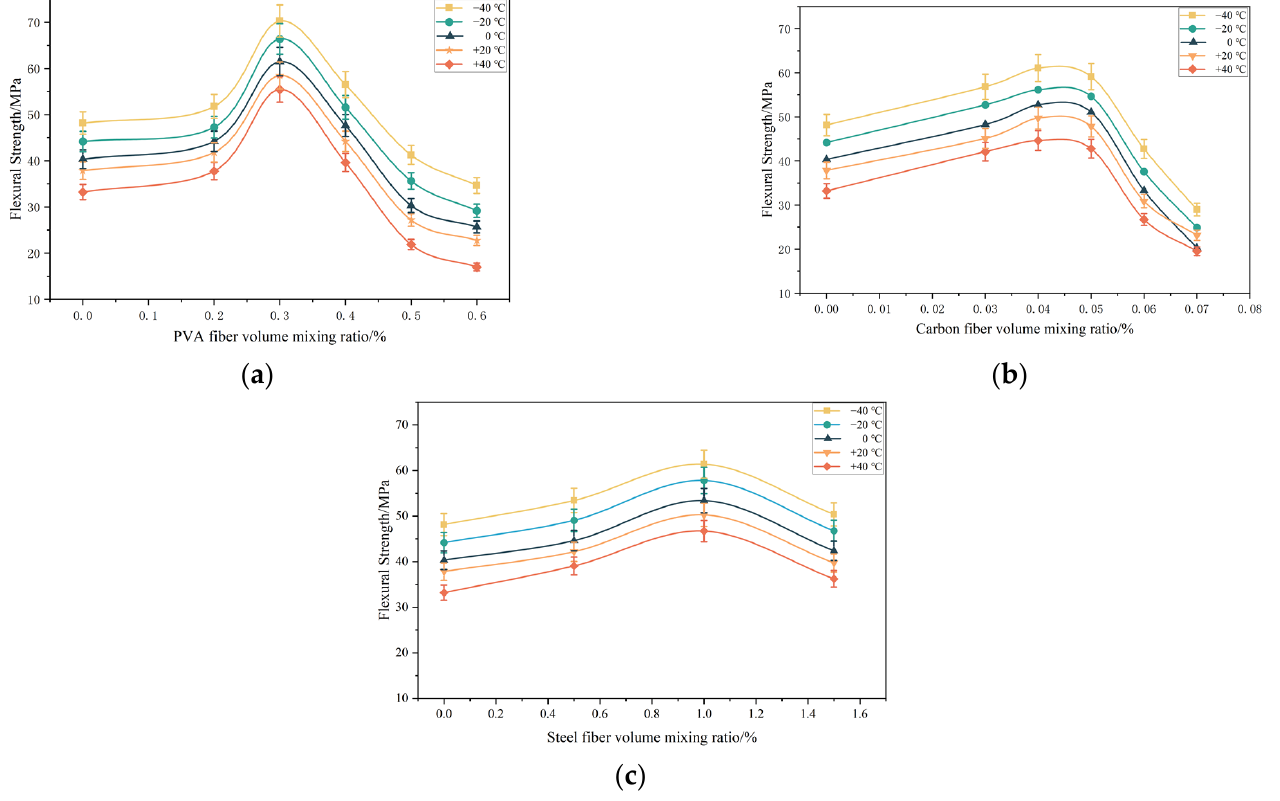
Figure 3. Variation curves of flexural strength with various fiber volume ratios. ( a ) PF-PUC; ( b ) CF-PUC; ( c ) SF-PUC.